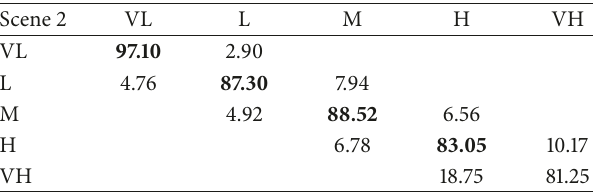
Table 6: The accuracy of our method on scene 2 (%).